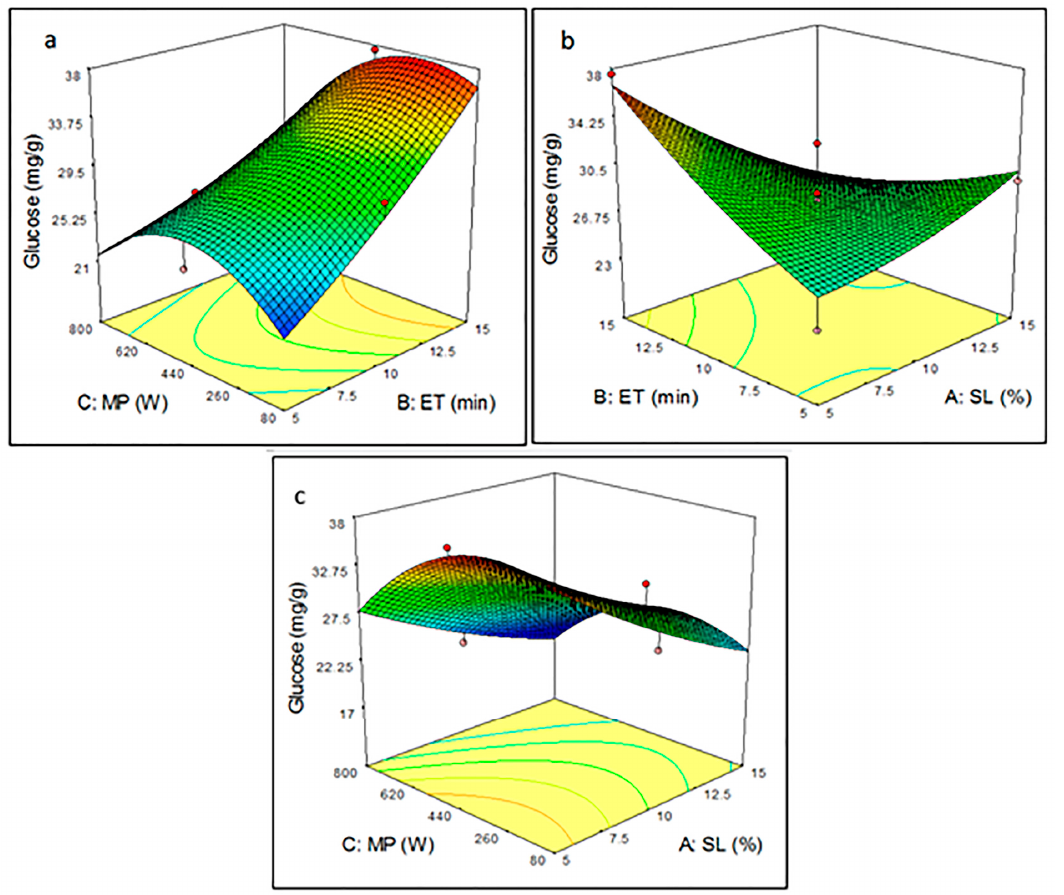
Figure 2. The effect of pretreatment parameters in MSA pretreatment on the glucose yield ( a ) with MP and ET at a constant SL, ( b ) with ET and SL at a constant MP, and ( c ) with MP and SL at a constant ET.